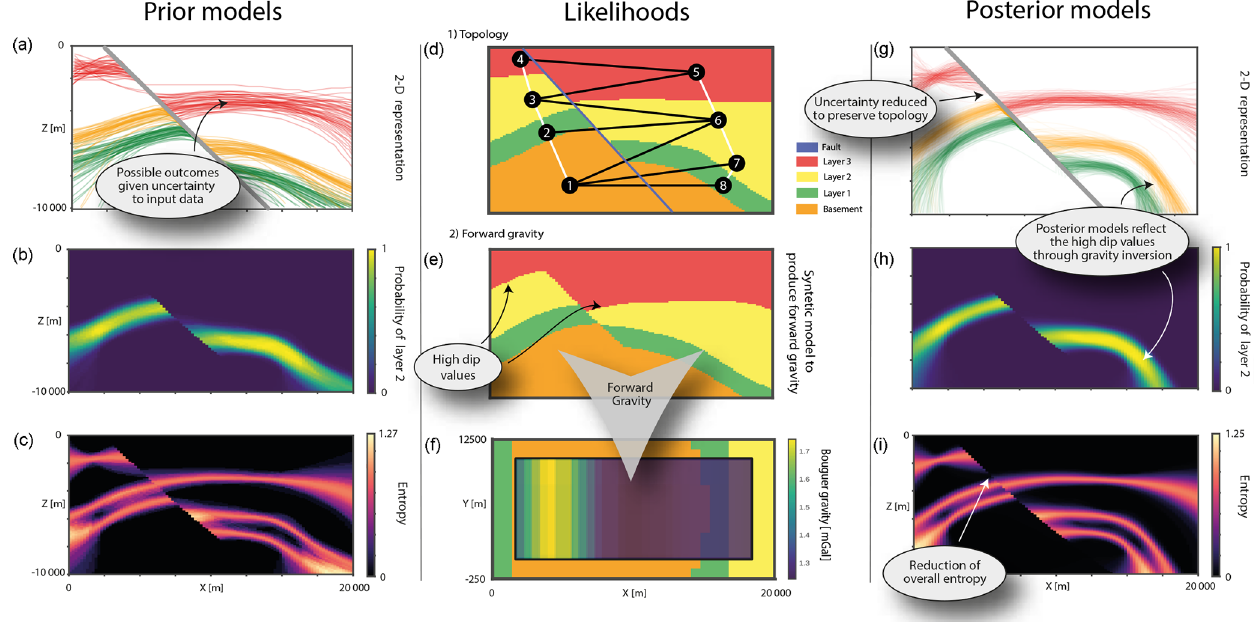
Figure 9. Probabilistic programming results on a cross section at the middle of the model ( Y = 10000m). (i) Priors UQ shows the un- certainty in geological models given stochastic values to the Z position of the input data (standard deviation, σ = 300): (a) 2-D interface representation; (b) probability of occurrence for Layer 2; (c) information entropy. (ii) Representation of data used as likelihood functions: (d) ideal topology graph; (e) synthetic model taken as reference for the gravity inversion; (f) reference forward gravity overlain on top of an XY cross section of the synthetic reference model. Posterior analysis after combining priors and likelihood in a Bayesian inference: (g) 2-D interface representation; (h) probability of occurrence for Layer 2; (i) information